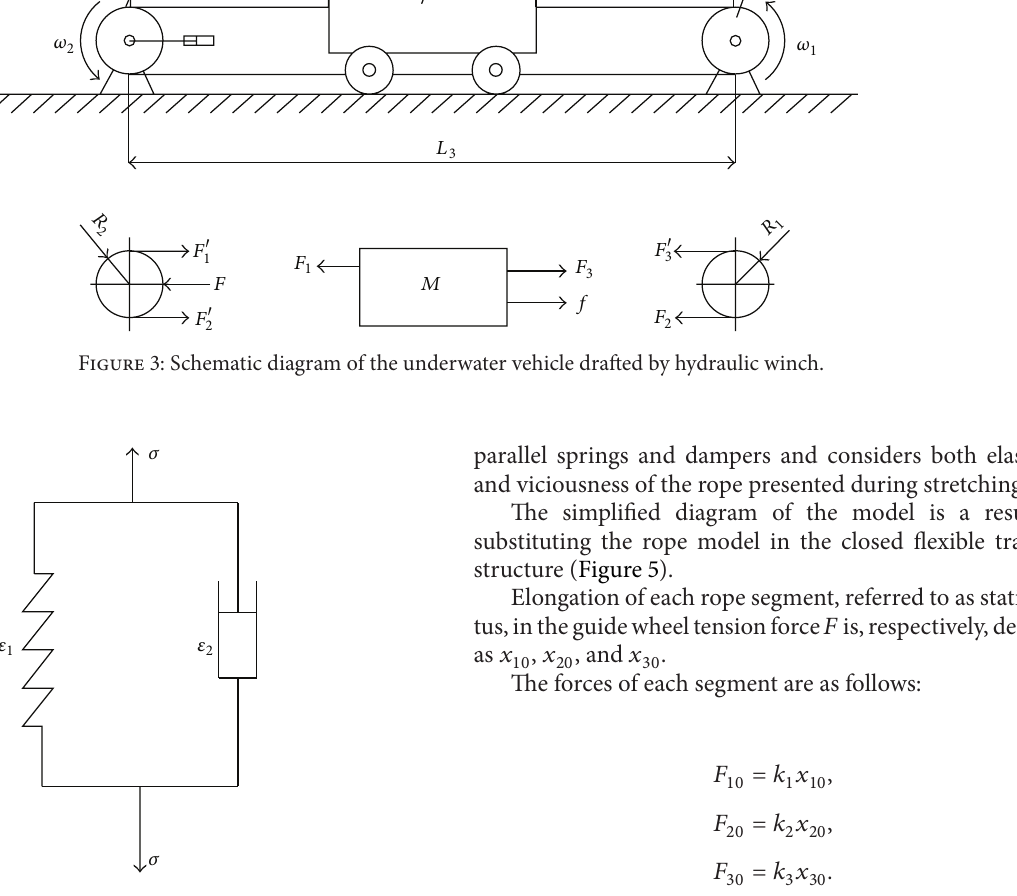
Figure 4: Kelvin-Voigt